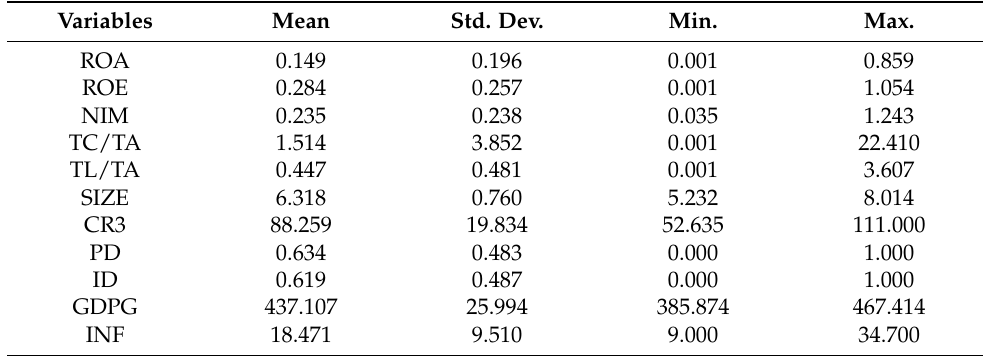
Table 1. Descriptive statistics of research variables.